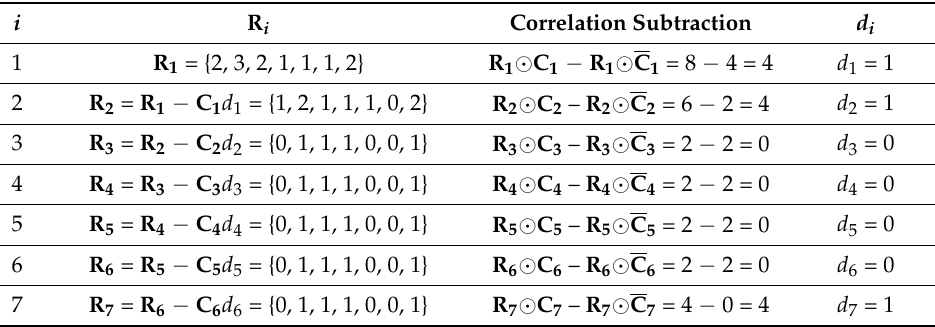
Table 2. A numerical example of illustrating the processes of MUI elimination in the proposed OCDMA receiver.